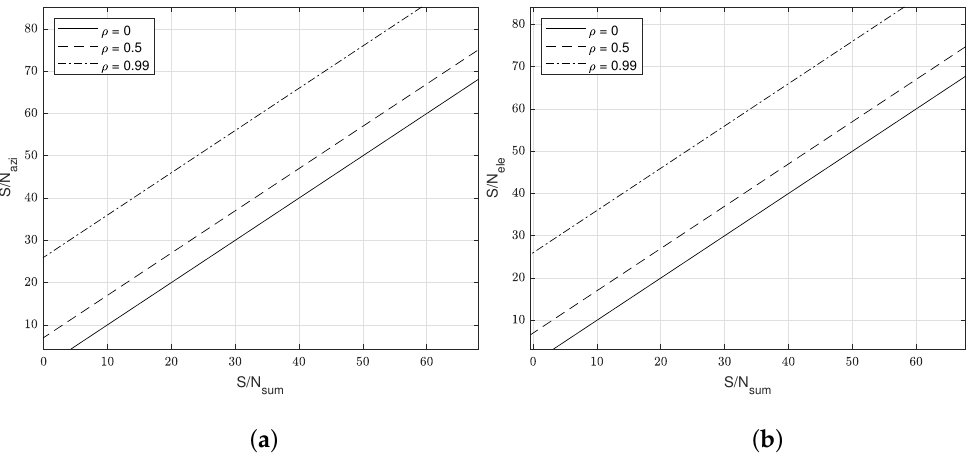
Figure 9. Difference channel SNR for sum channel SNR. ( a ) S/N azi for S/N sum . ( b ) S/N ele for S/N sum .